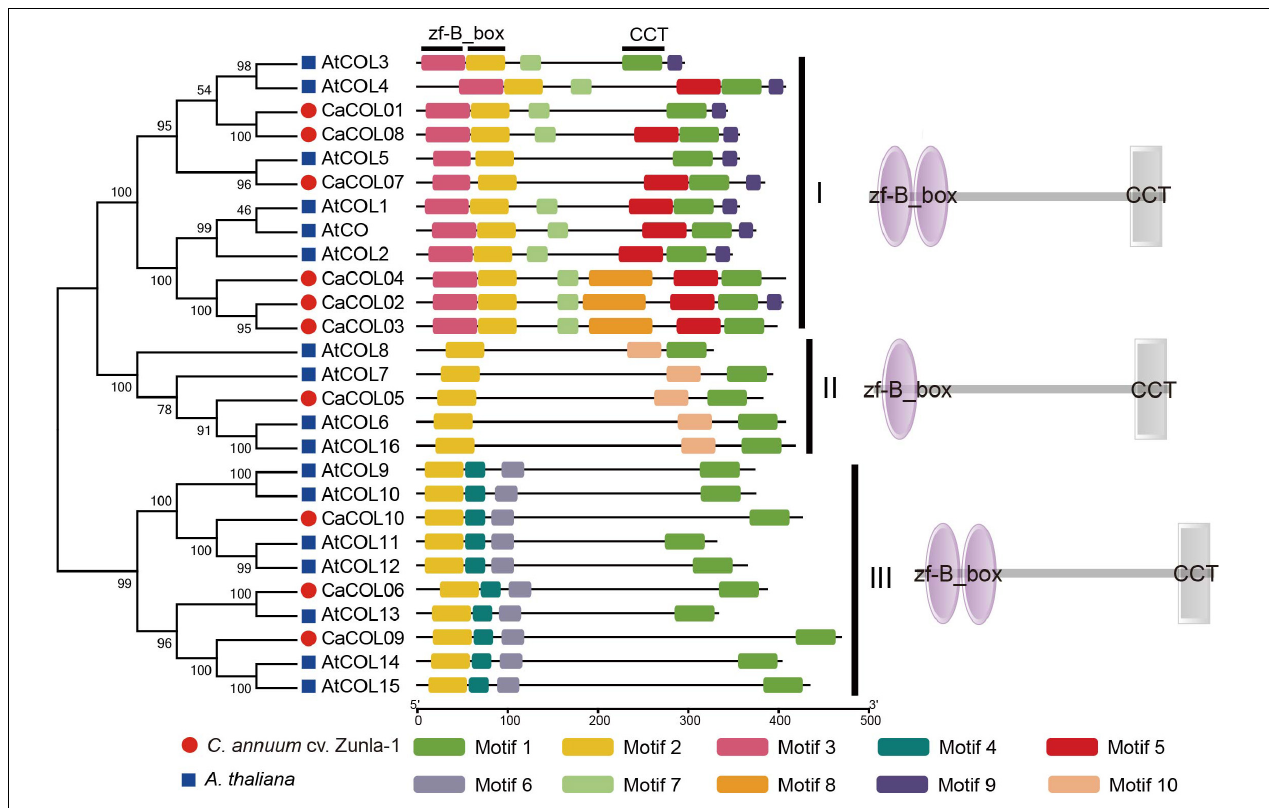
FIGURE 2 | Analysis of conserved domains of COL proteins in Capsicum annuum and Arabidopsis thaliana. CaCOLs and AtCOLs are indicated by red balls and blue boxes, respectively. B-box and CCT domains were annotated by the SMART database.